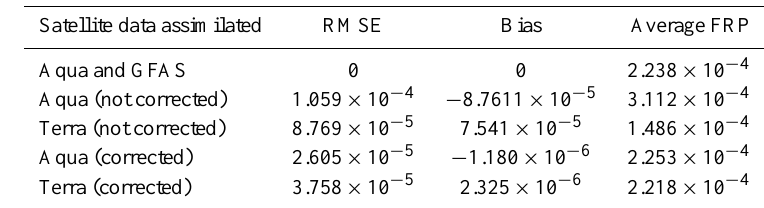
Table 4. RMSE and bias of mean global FRP in mWm − 2 for the year 2012 for Full-GFAS (reference), uncorrected Aqua- and Terra-GFAS, and corrected Aqua- and Terra-GFAS, against Full-GFAS FRP